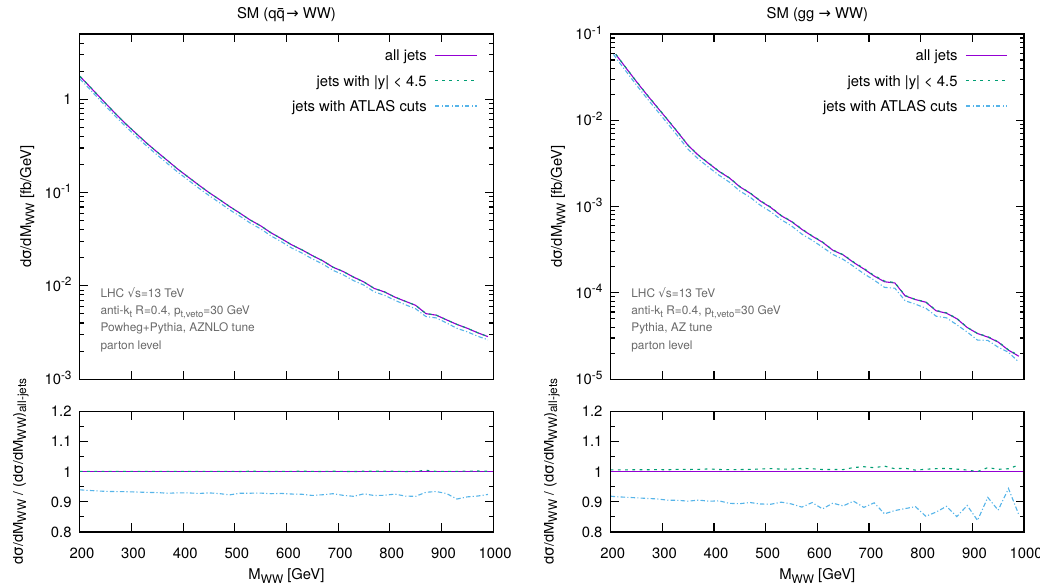
Figure 9 . Impact of di(cid:11)erent cuts on the jets on d(cid:27)=dM WW in the SM for q (cid:22) q (left) modelled with POWHEG+PYTHIA and gg (right) modelled with plain PYTHIA .